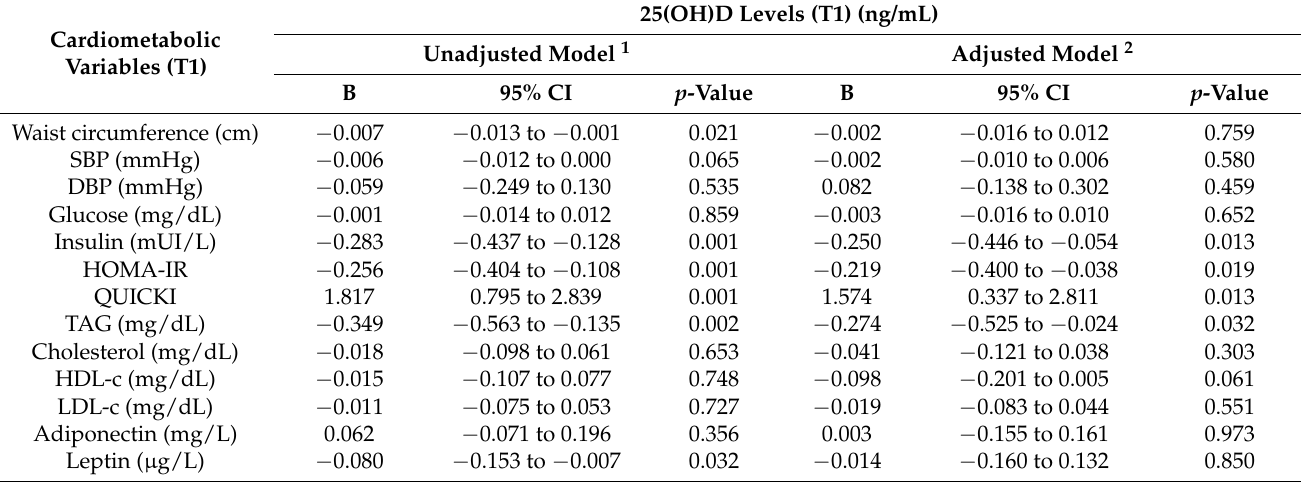
Table 2. Multivariable linear regression analysis between cardiometabolic variables and levels of 25(OH)D, both at the pubertal stage